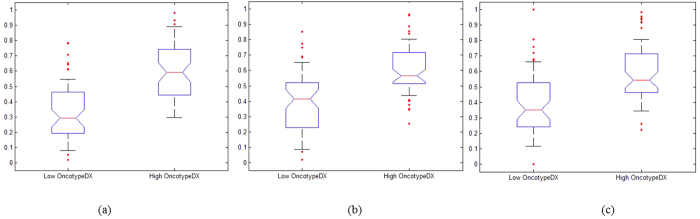
Box-and-whisker plots for mean feature values of three best features corresponding to (a) dynamic histogram of oriented gradient (DHoG), (b) dynamic local binary pattern (DLBP), and (c) pharmacokinetic (PK) feature across all patient studies. The plots suggest that DHoG and DLBP have improved separability between low versus high OncotypeDX estrogen receptor (ER)-positive breast tumors compared to the PK features.